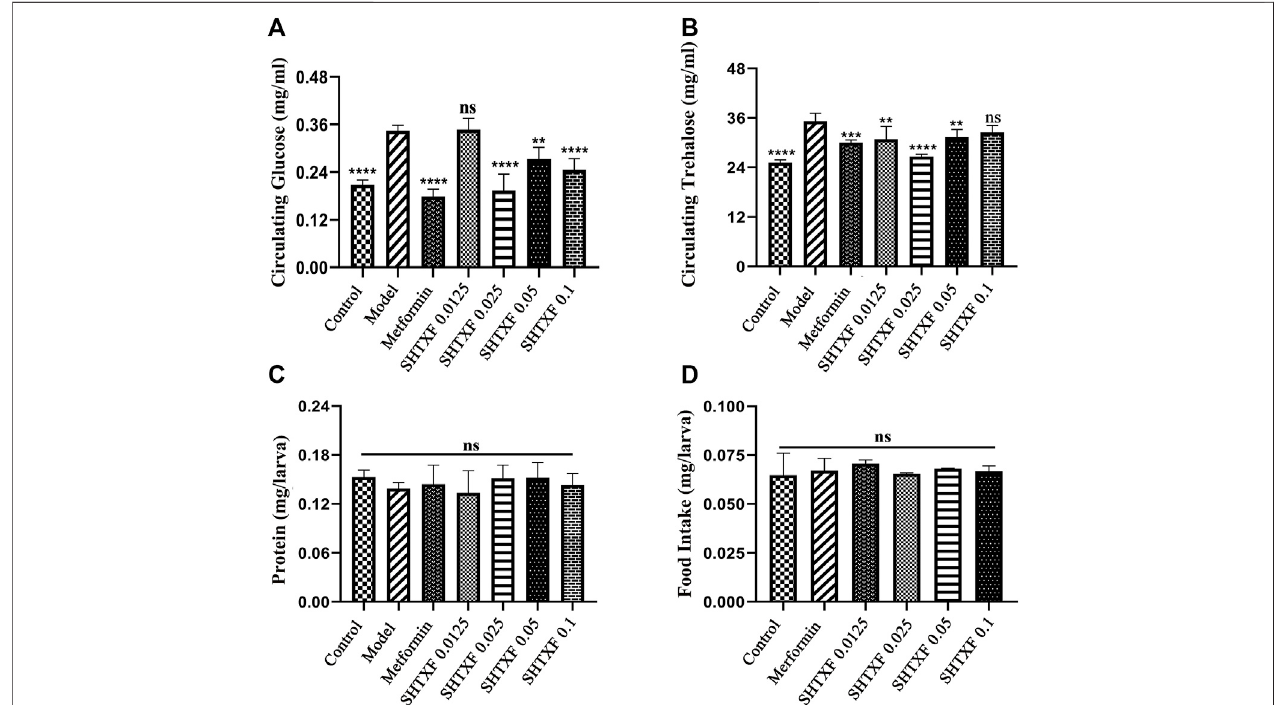
FIGURE 3 | SHTXF reduced the increased level of glucose and trehalose in Cg > InR K1409A fi les. (A,B) Assays for circulating the metabolites were performed on the wandering third-instar larvae of indicated groups: hemolymph glucose [ (A) , 10 – 12 larvae per pool, n = 5], hemolymph trehalose [ (B) , 6 – 8 larvae per pool, n = 5]. (C) Measurement of 20-min food intake by early third-instar larvae as calculated by blue food ingestion (6 – 8 larvae per pool, n ≥ 3). (D) Amount of protein indicates the soluble fraction in 0.05% PBST after heat inactivation (3 larvae per pool, n = 5). Error bars indicate the standard deviation (SD). One-way ANOVA with Bonferroni ’ s multiple comparison test was used to compute the p values: **** p < 0.0001, *** p < 0.001, and ** p < 0.01. ns, no signi fi cant difference.